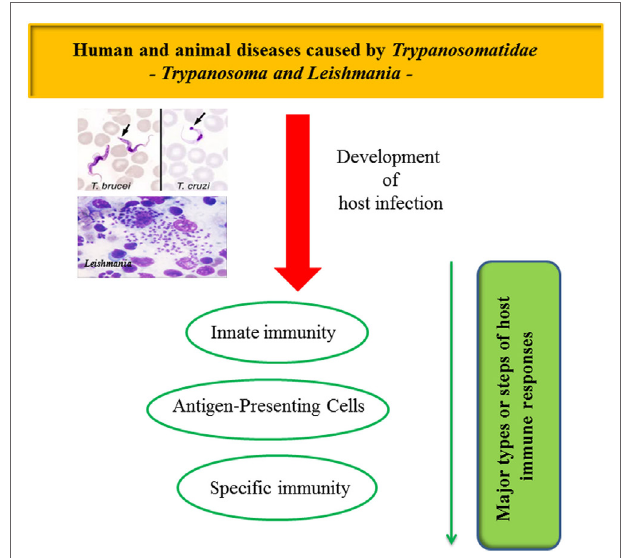
FiGURe 1 | Mechanisms used by trypanosomatids to escape their host deleterious immune response